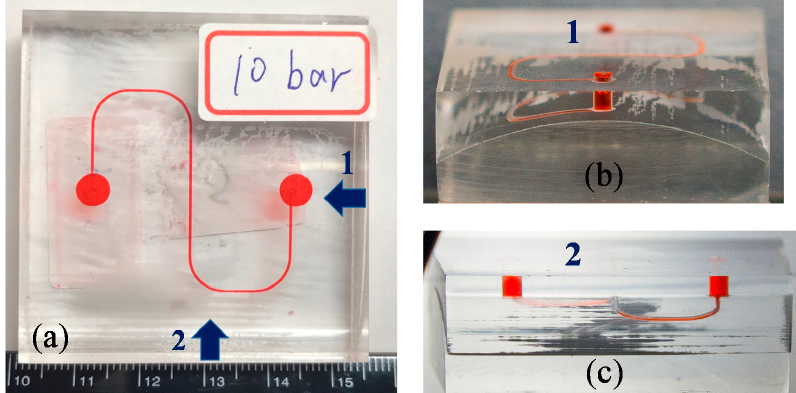
Figure 9. ( a ) Top view of the bonded nonplanar PMMA microfluidic chip with a S ‐ microchannel; ( b ) the side view of the bonded nonplanar PMMA microfluidic chip from location 1; ( c ) the side view of the bonded nonplanar PMMA microfluidic chip from location 2.